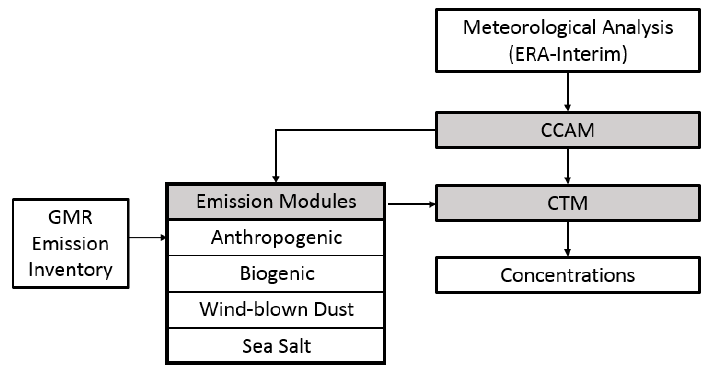
Figure 1. Schematic diagram of the CCAM-CTM modelling system.